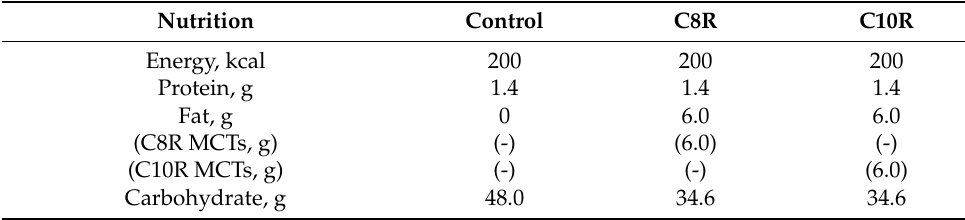
Table 1. Test drinks in the present study.